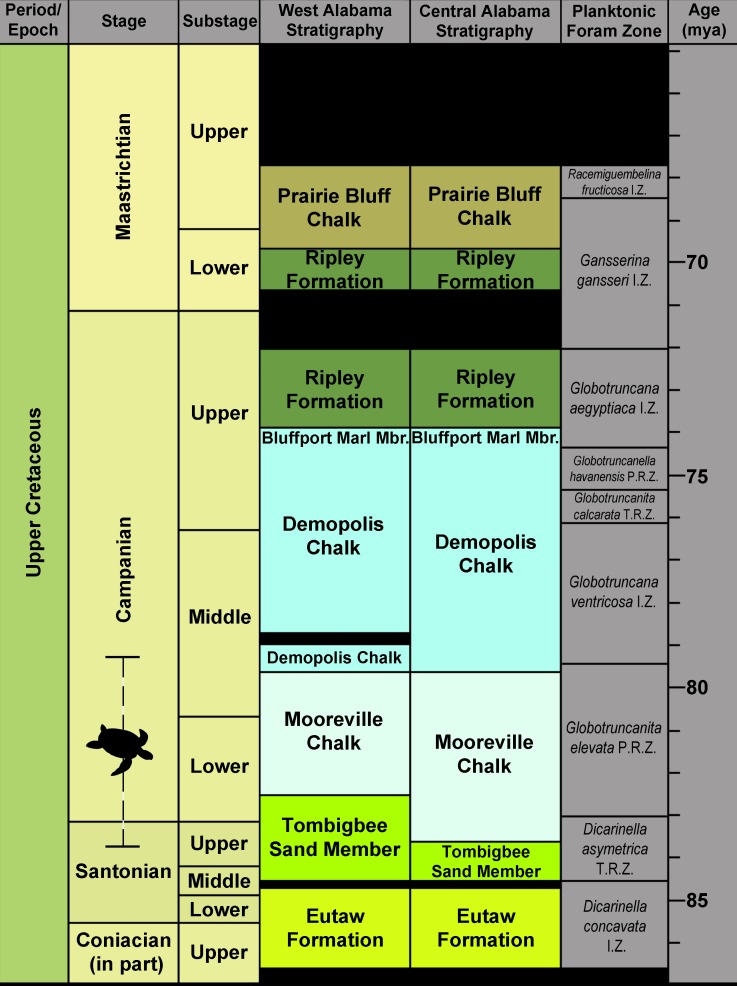
Generalized Santonian through Campanian surface stratigraphy of western and central Alabama.Stratigraphy follows that of Mancini, Puckett & Tew (1996) and Dockery (2008). Planktonic foraminferal zones after Caron (1985) and Mancini & Puckett (2005). Modified from Gentry et al. (2018).